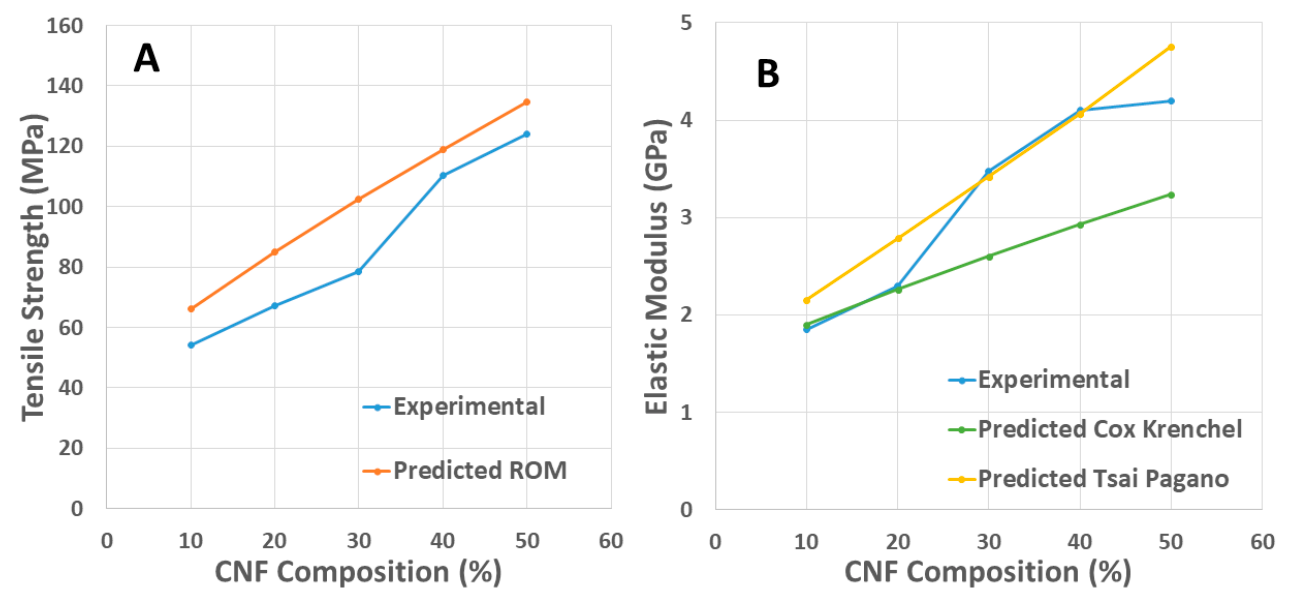
Figure 3. Experimental and theoretically predicted tensile strength ( A ) and modulus ( B ) values for PA6-CNF nanocomposites.